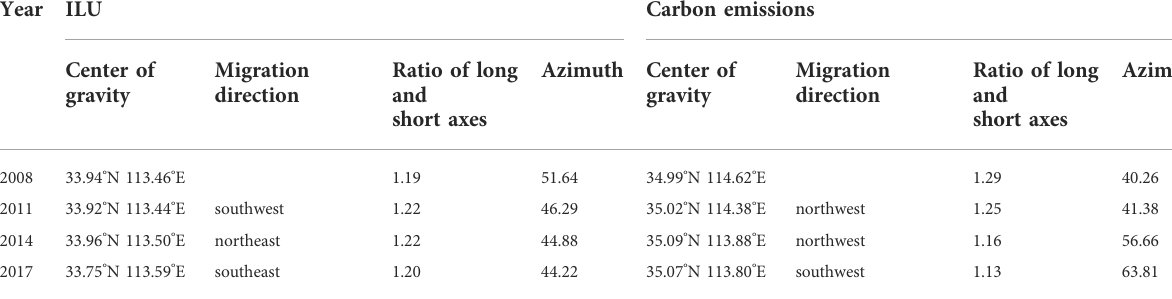
TABLE 5 Changes of ellipse parameters of standard deviation of ILU and carbon